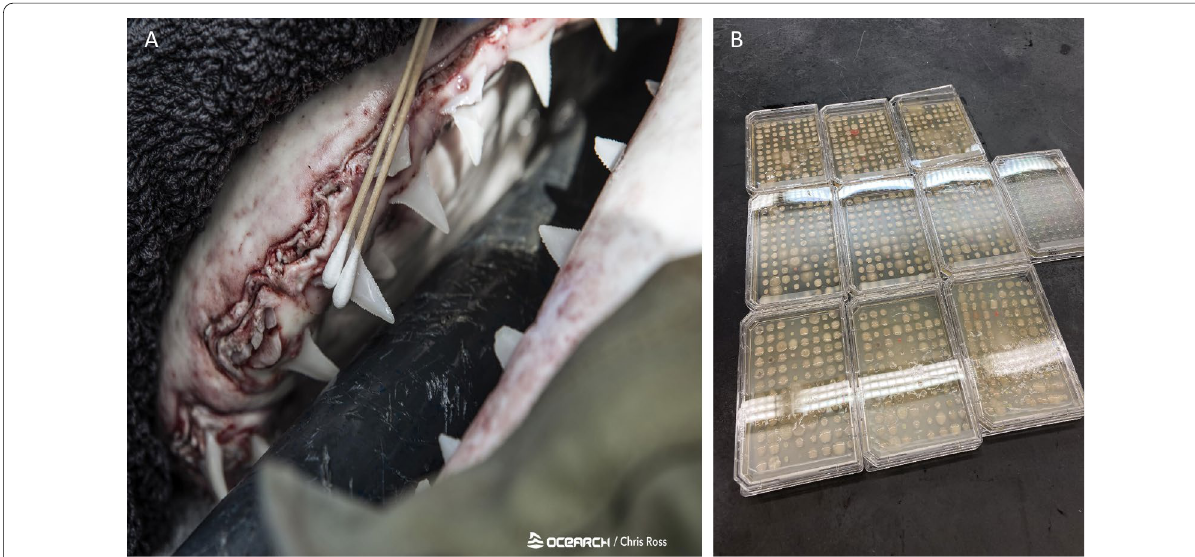
Fig. 5 The elasmobranch tooth microbiome ( A ) has been of interest for medical treatment of elasmobranch bites on human swimmers, although the incidence of negative elasmobranch–human interactions is rare. Culture‑based exploration ( B ) is an avenue for future research to examine biochemical and ecological aspects of elasmobranch‑associated microbes. Panel A Oral swab being collected from a secured white shark (Chris Ross, OCEARCH). Panel B Culture plates from elasmobranch oral swabs (Kim Ritchie, University of South Carolina